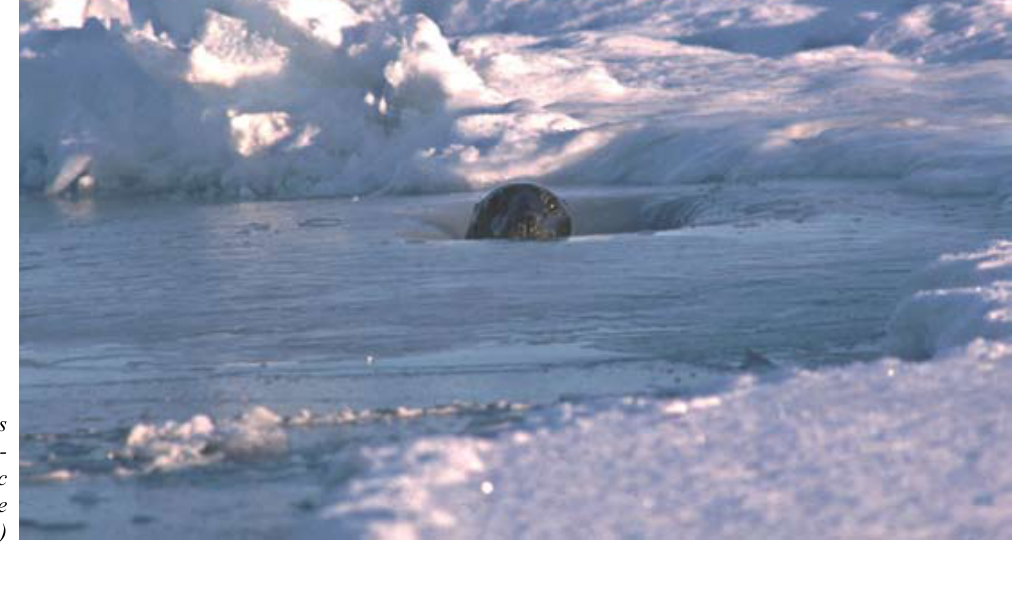
Fig. 2. Historical minimum popula - tion size of grey seals in the Baltic, estimated from hunting statistics (Harding and Härkönen 1999). An unknown number of killed seals were not registered (lean seals sank and wounded seals were not found) and the 4 different lines show how the population size estimate is affected by different proportions of unregistred mortality (0% to 30%). The popula - tion trend after 1990 was based on photo-id studies (Hiby et al. 2007), and on analyses of land based counts (this